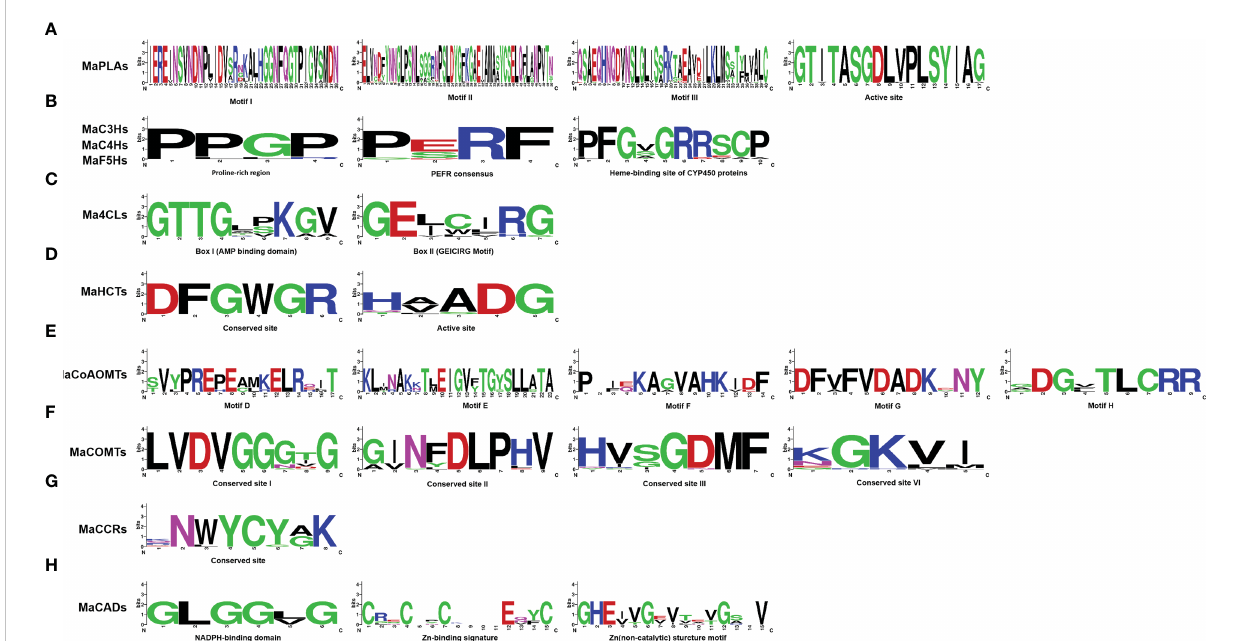
FIGURE 1 Sequence logo of the lignin biosynthesis proteins motifs. The height of each amino acid represented the relative frequency of the amino acid at that position. (A) Phenylalanine ammonialyase(PAL), (B) coumarate 3-hydroxylase (C3H), cinnamate 4-hydroxylase (C4H) and ferulate 5-hydroxylase (F5H), (C) 4-coumarate: CoA ligase (4CL), (D) hydroxycinnamoyl-CoA shikimate/quinate transferase (HCT), (E) caffeoyl-CoA-O-methyltransferase (CcoAOMT), (F) caffeic acid Omethyltransferase (COMT), (G) cinnamoyl CoA reductase (CCR), (H) cinnamyl alcohol dehydrogenase